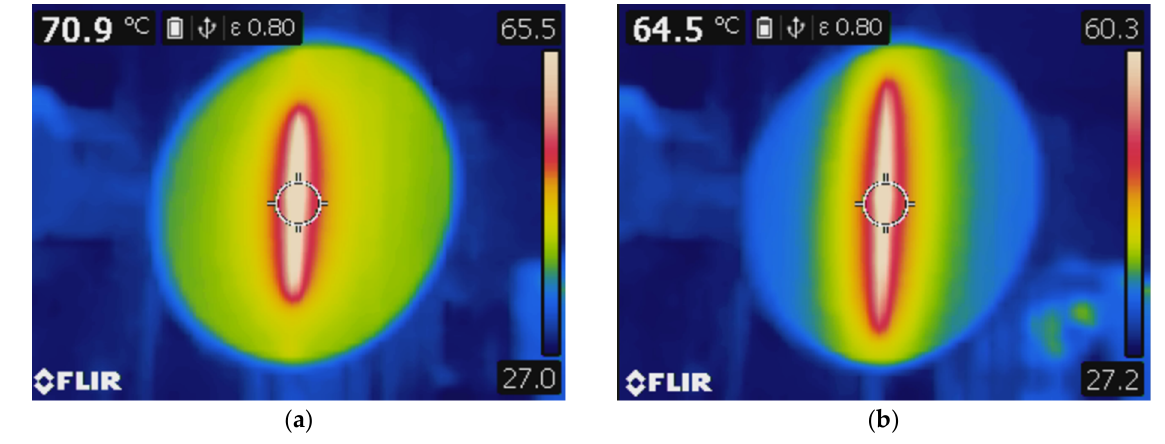
Figure 8. Captured images of laser projected single dipole pattern with dimensions: ( a ) 30 mm × 2.9 mm (~3.3 GHz); ( b ) 39 mm × 2.9 mm (~3 GHz).